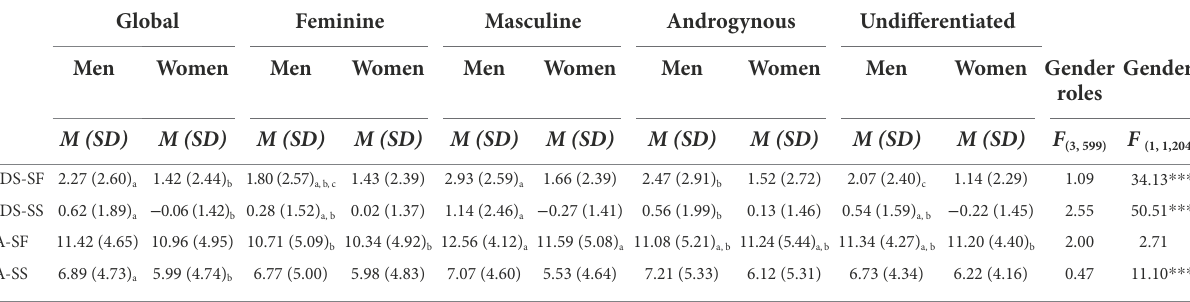
TABLE 3 Differences in Index of Double Standard for Sexual Freedom, Index of Double Standard for Sexual Shyness, Acceptance of sexual freedom and Acceptance of sexual shyness across gender and gender roles. Global Feminine Masculine Androgynous Undifferentiated